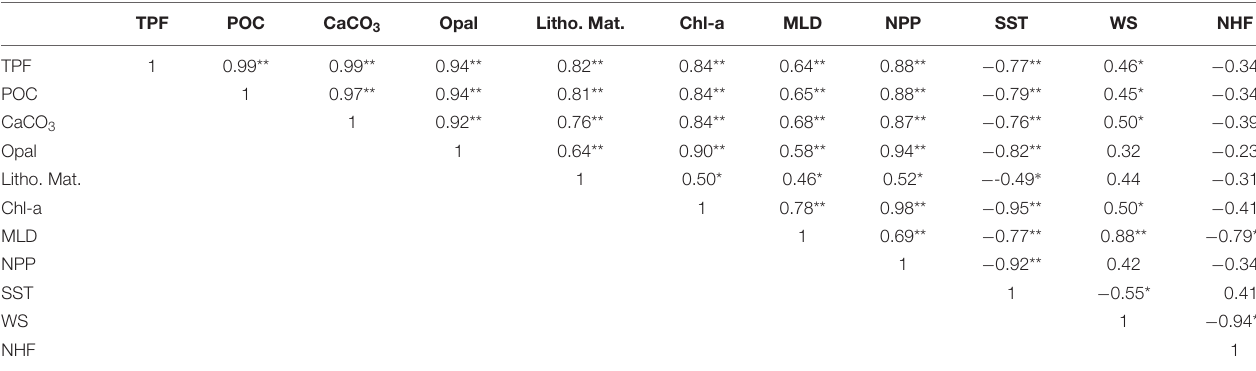
TABLE 3 | Pearson correlation coefficient ( R ) between daily total particle flux (TPF), particulate organic carbon (POC), CaCO 3 fluxes, opal fluxes, lithogenic matter fluxes (Litho. Mat.), surface chlorophyll-a concentration (Chl-a), mixed layer depth (MLD), net primary production (NPP), sea surface temperature (SST), wind speed (WS) and net heat flux (NHF) at SCS-N